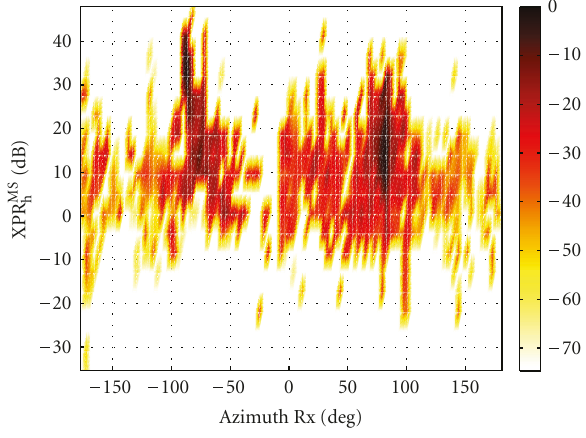
Figure 21: Power spectrum of P MS of the SCs. XPR MS h